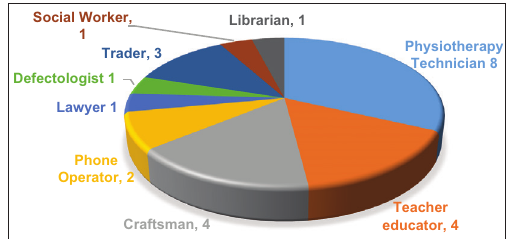
CHART 2. Respondents’ professions (Social Worker (1)–